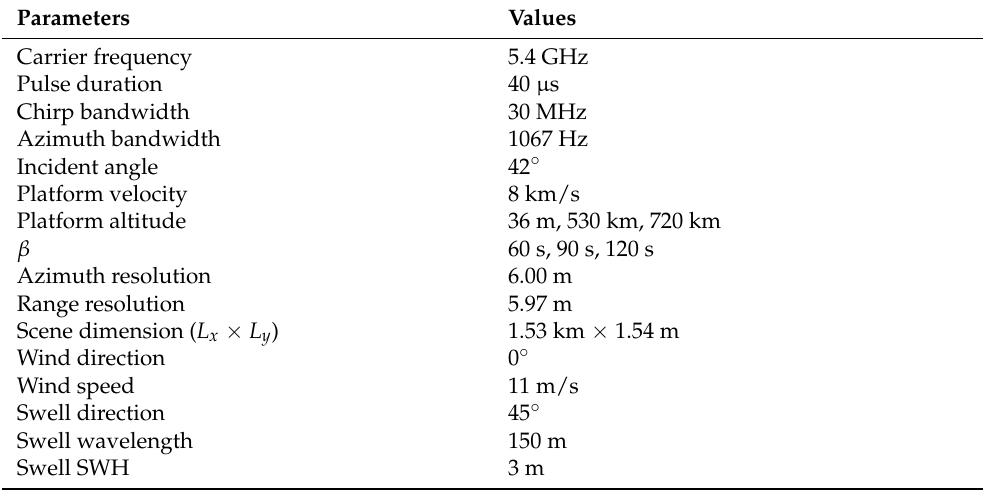
Table 3. The parameters of radar and ocean waves.